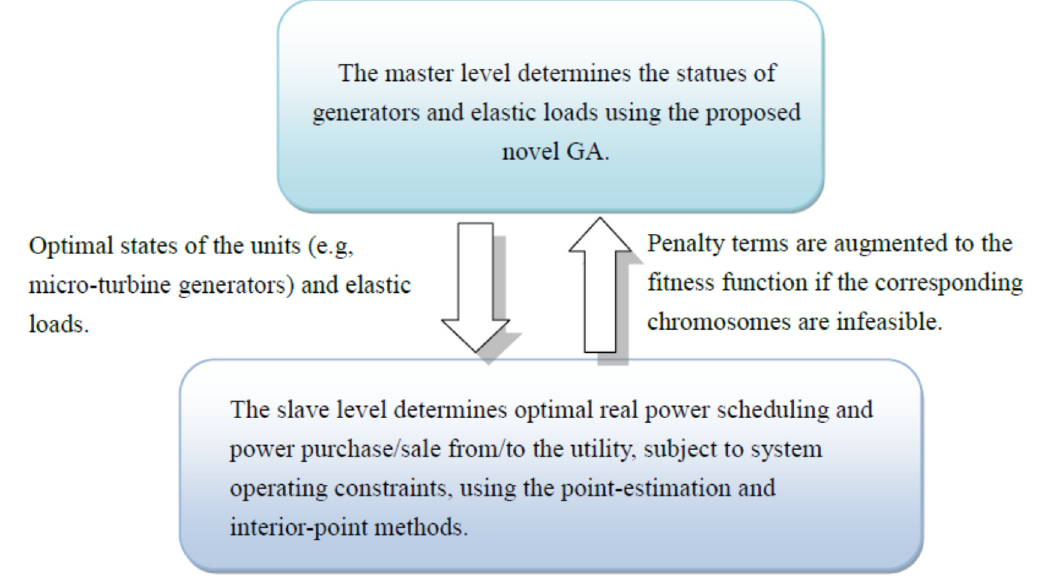
Figure 8. The schematic master–slave iterations.